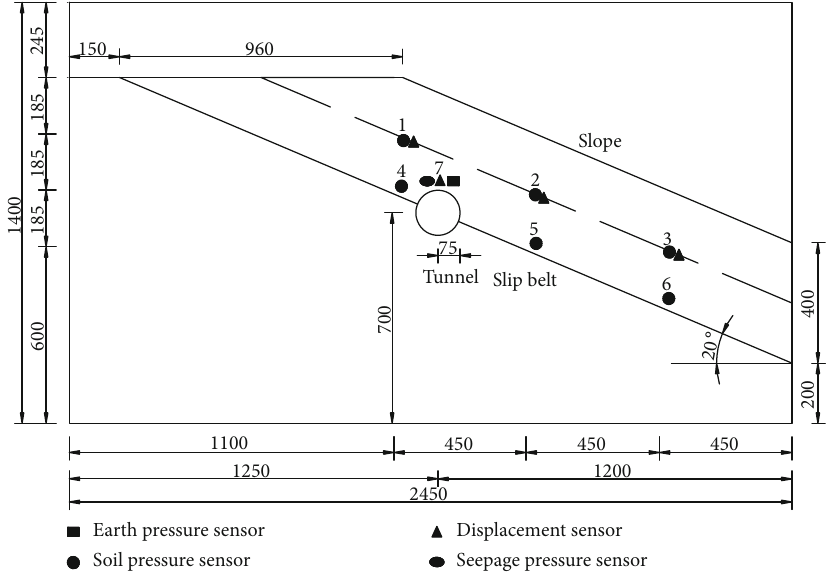
Figure 11: The section view of the tunnel-slope system model experiment (unit: mm).